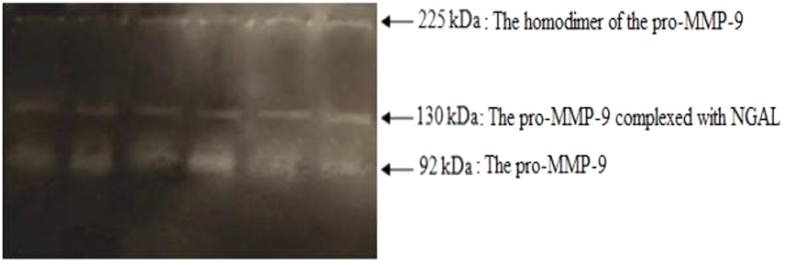
Representative gelatin zymograms of serum samples with MMP-9 forms.